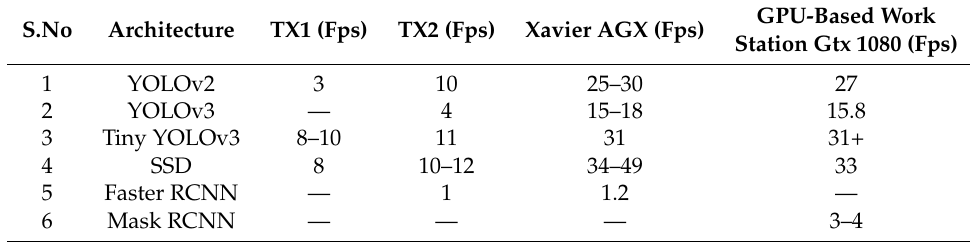
Table 13. Performance comparison between Jetson modules and GTX 1080 for real-time object